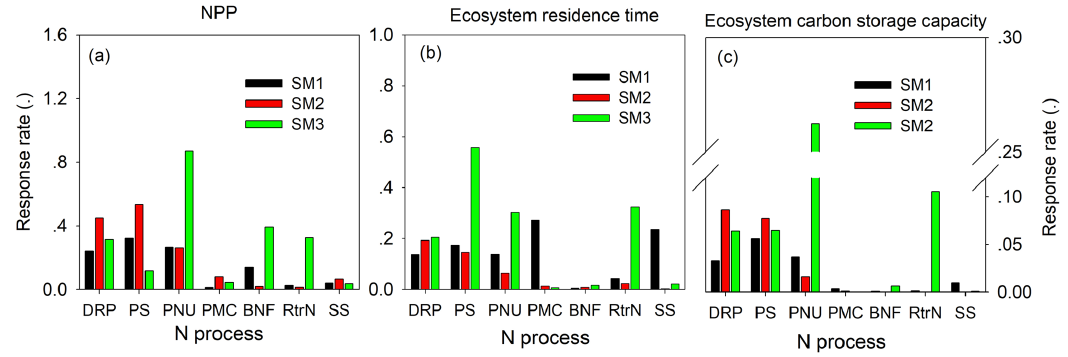
Figure 10. The sensitivity of nitrogen processes to NPP (a) , ecosystem residence time ( τ E , b ), and ecosystem C storage capacity (c) among three carbon–nitrogen coupling schemes (SM1, SM2, and SM3). DRP: downregulation of photosynthesis; PS: plant tissue C : N ratio; PNU: plant N uptake; PMC: plant and microbe competition; BNF: biological N fixation; RtrN: retranslocation N; SS: soil pool C : N